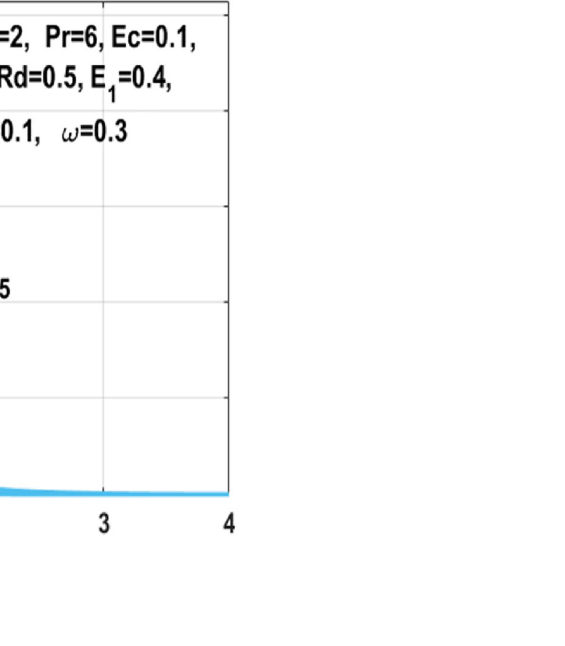
skin friction coefficient. Figure 11 illustrates the effect of K on the coefficient of skin friction C fs through the Hartmann number M . Here, the curvature parameter K and the magnitude of the skin friction coefficient are directly proportional to each other because when K is larger, radius of surface decreases, it creates more resist- ance for fluid particles which leads to higher value of the skin friction coefficient C fs . In Fig. 12, we have analyzed the effects of suction and Eckert number on the Nu s which states that the Nusselt number Nu s is negatively connected to the Eckert number. Figures 13 and 14 discusses the relationship between the suction parameter S and the change in magnitude of local Nusselt number. This is displayed on a graph for various radiation parameter values and Hartmann number M . These figures illustrate the indirect relationship among the Nusselt number and the radiation parameter Rd as well as a reverse trend is observed for the Hart- mann number M . Figures 15 and 16 show the effect of temperature difference parameter ω and Soret number Sr on the Sherwood number Sh s versus activation energy E 1 . As long as the temperature difference parameter